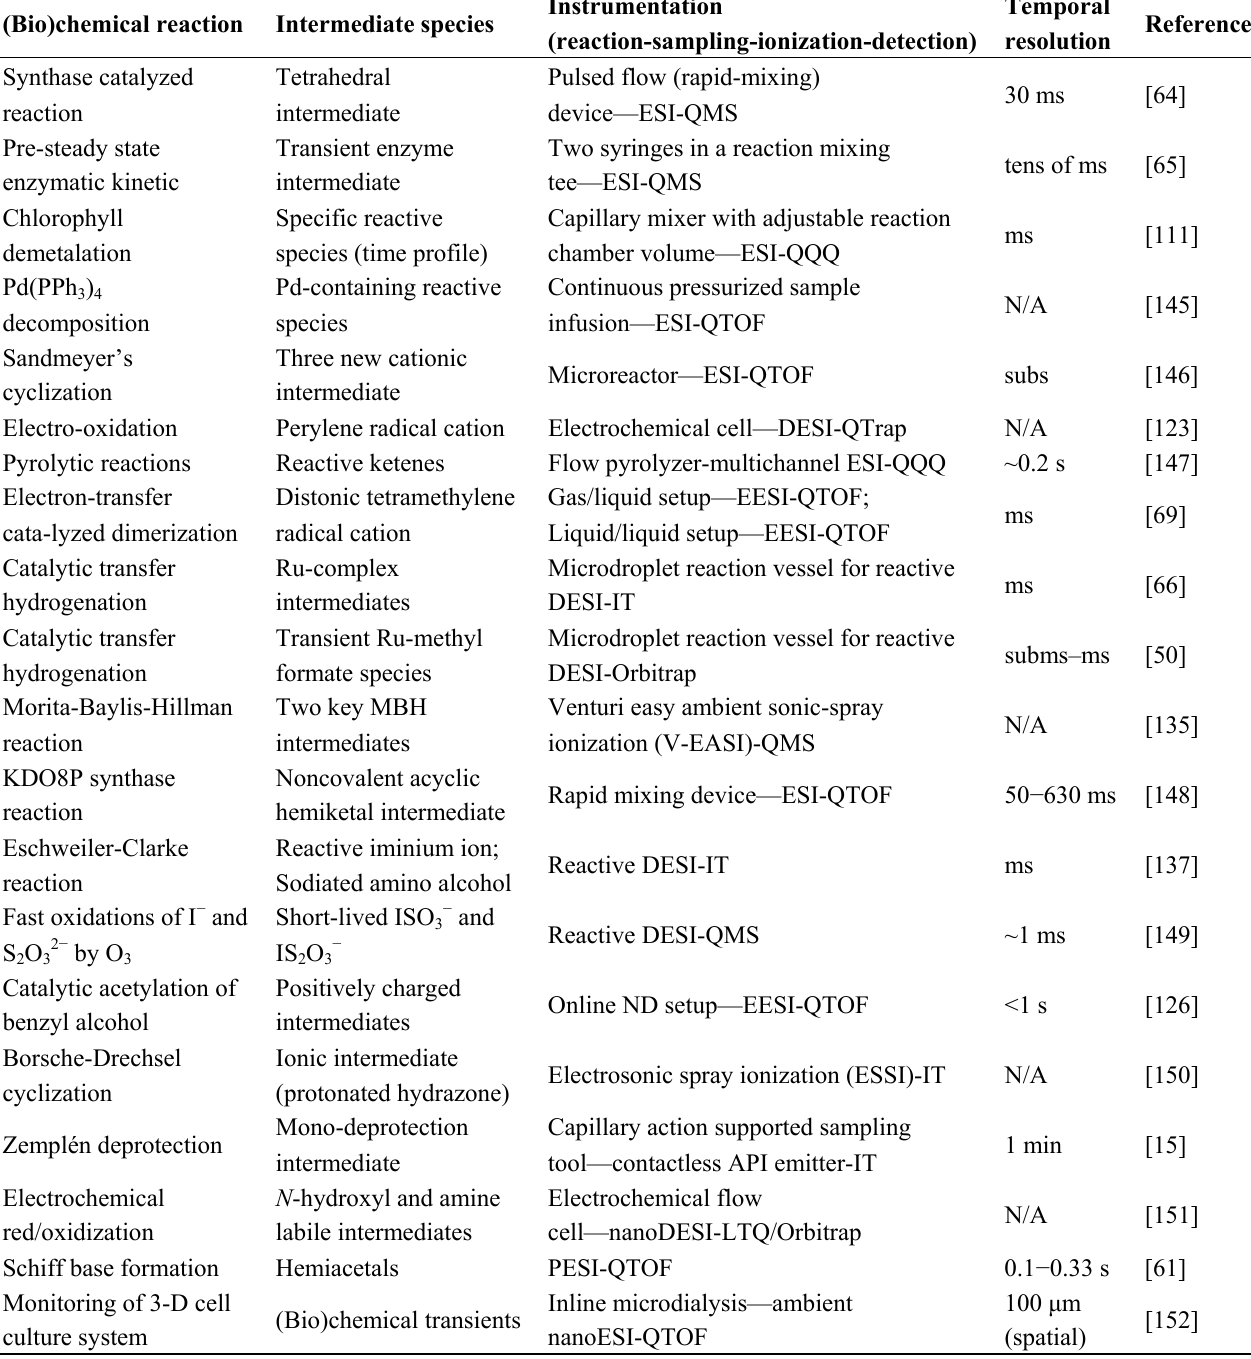
Table 3. Representative applications of time-resolved ESI-MS for monitoring fast reactions and intermediate